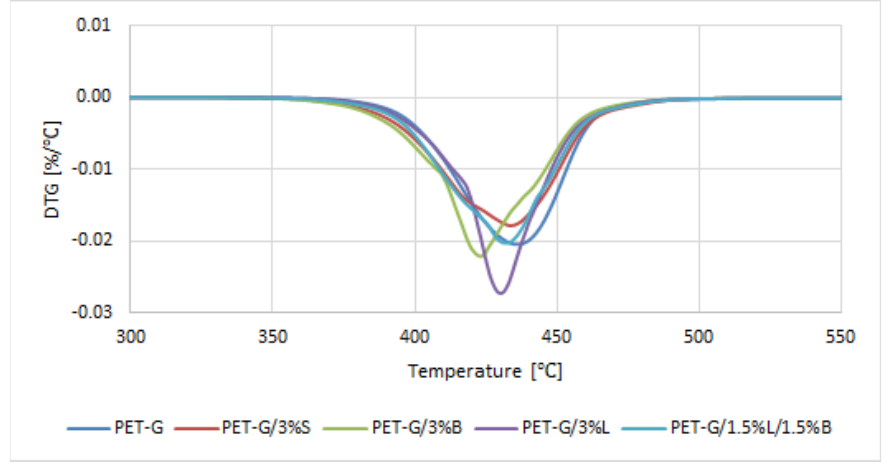
Figure 8. Results of DTG analysis (mass change derivative curve) of PET-G polymer and composites based on PET-G.